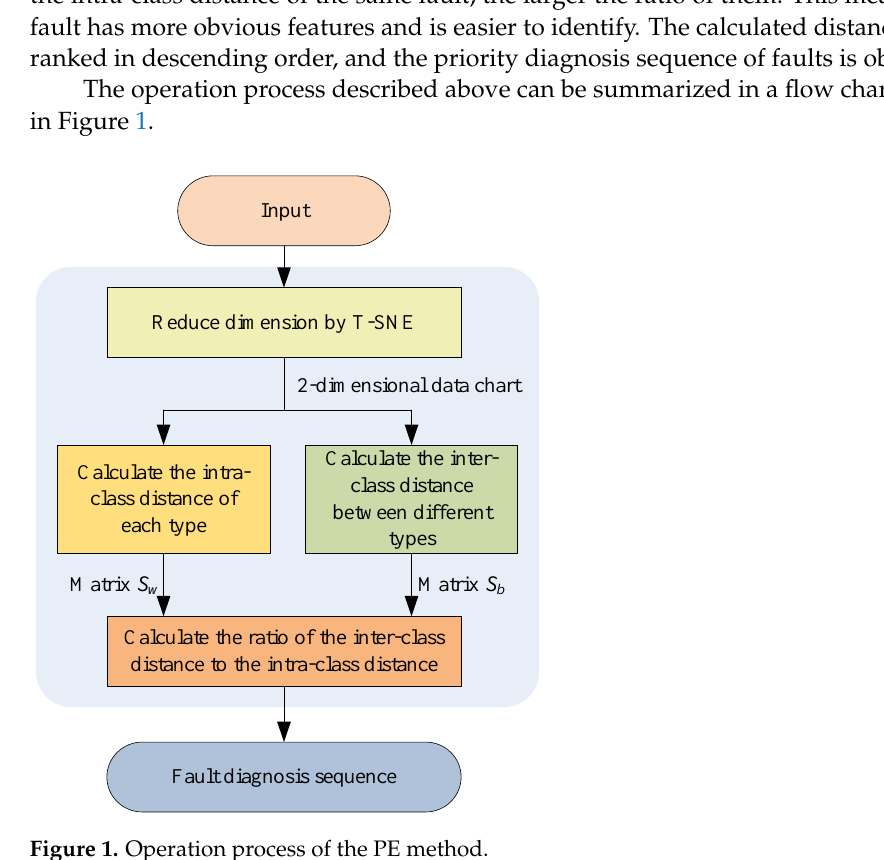
Figure 1. Operation process of the PE method.